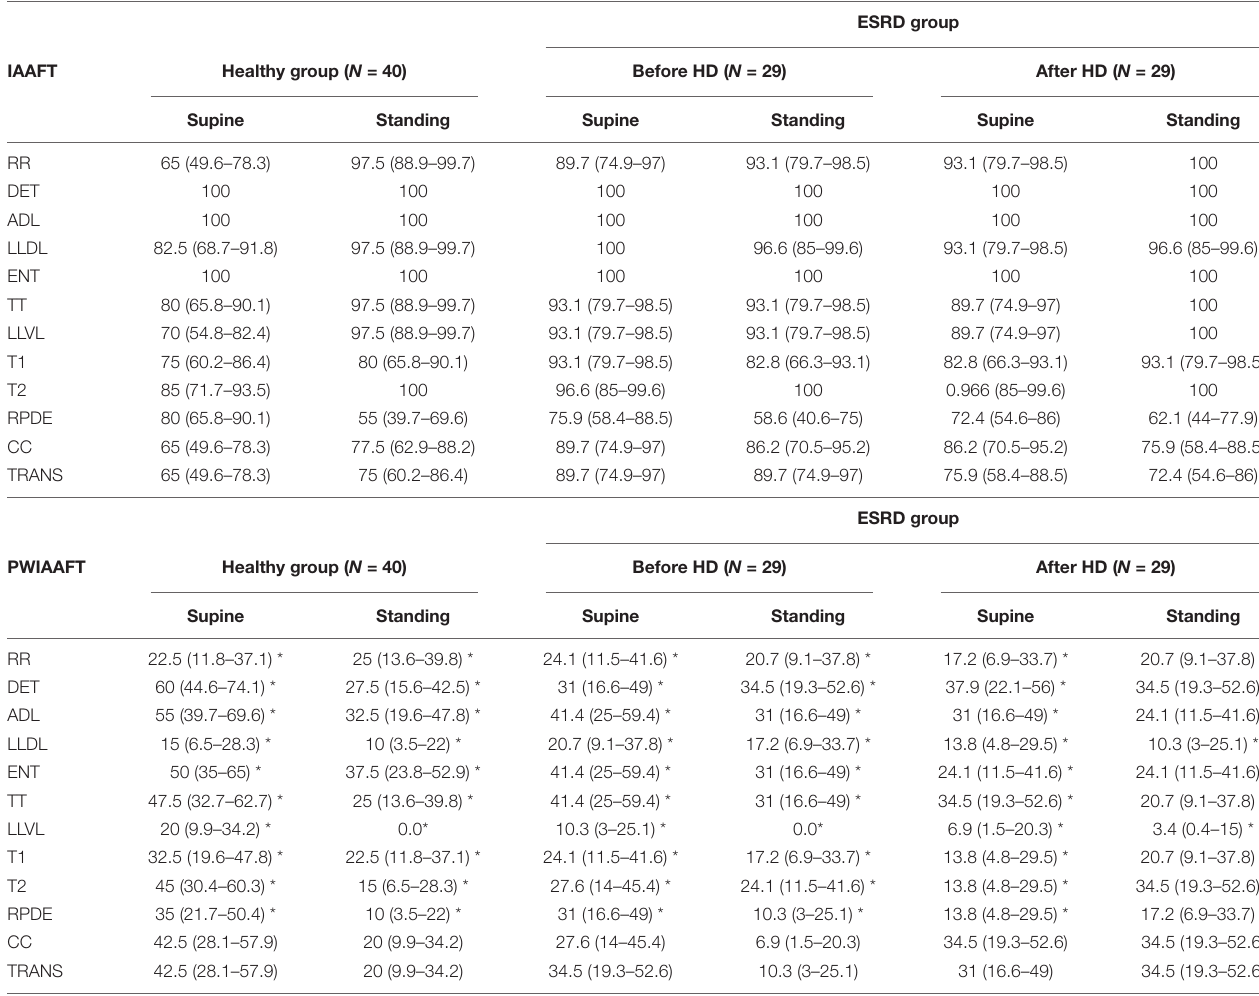
TABLE 2 | Percentage (95% confidence Interval) of heart rate variability (HRV) time series in every group that reject the null hypothesis according to the results of different recurrence quantitative analysis (RQA) indices.